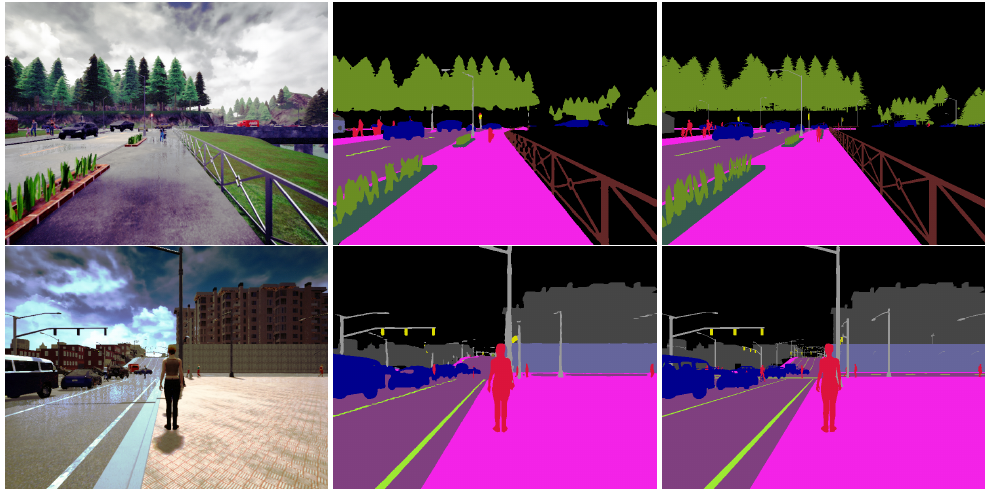
Figure 3. Two examples of model inference. From left to right: raw image, model prediction and ground truth.